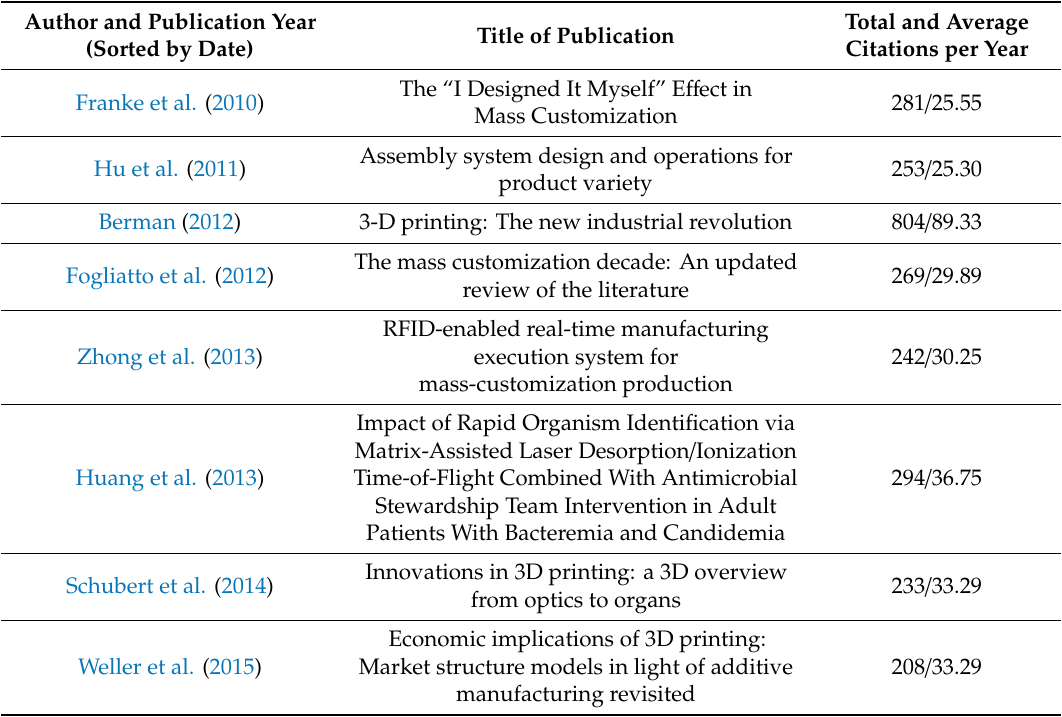
Table 1. The 15 most cited publications in the MC domain in 1990–2020 .